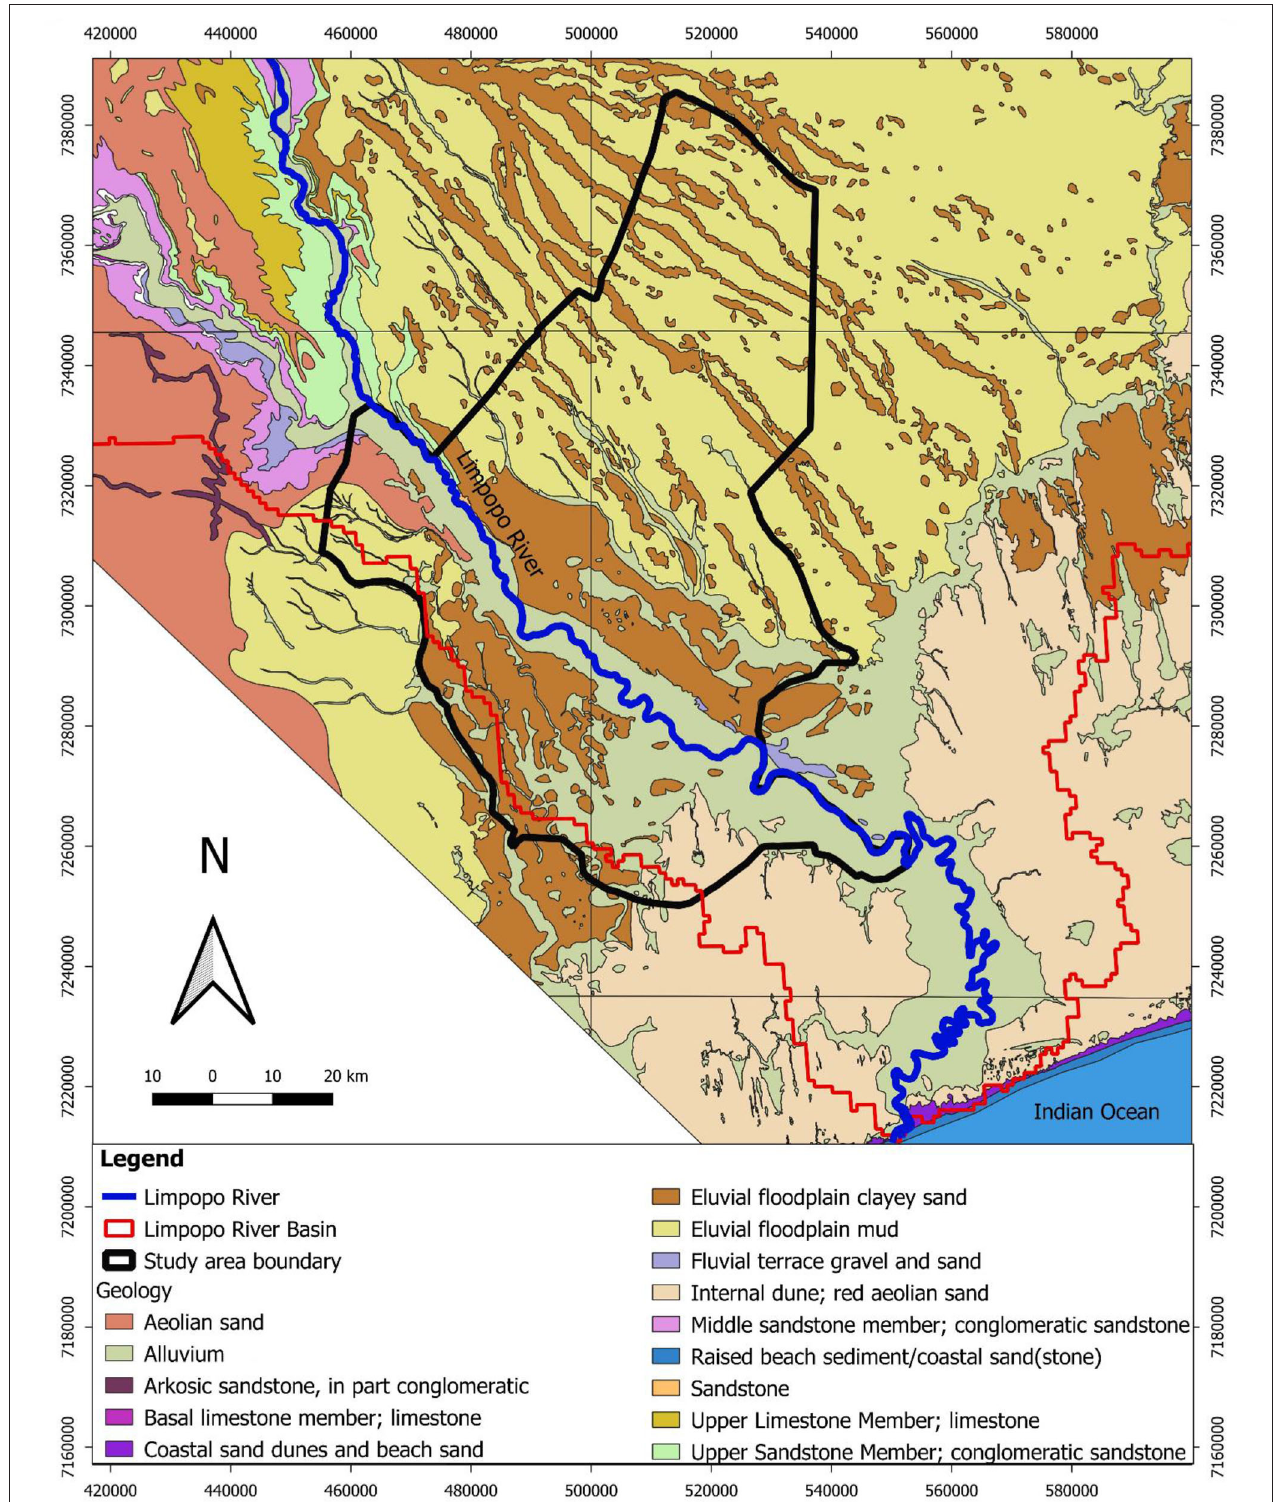
FIGURE 2 | Geological map of the Limpopo River basin in Mozambique (provided by the National Directorate for Geology) showing the dominant Quaternary alluvium deposits underlying the Limpopo River.